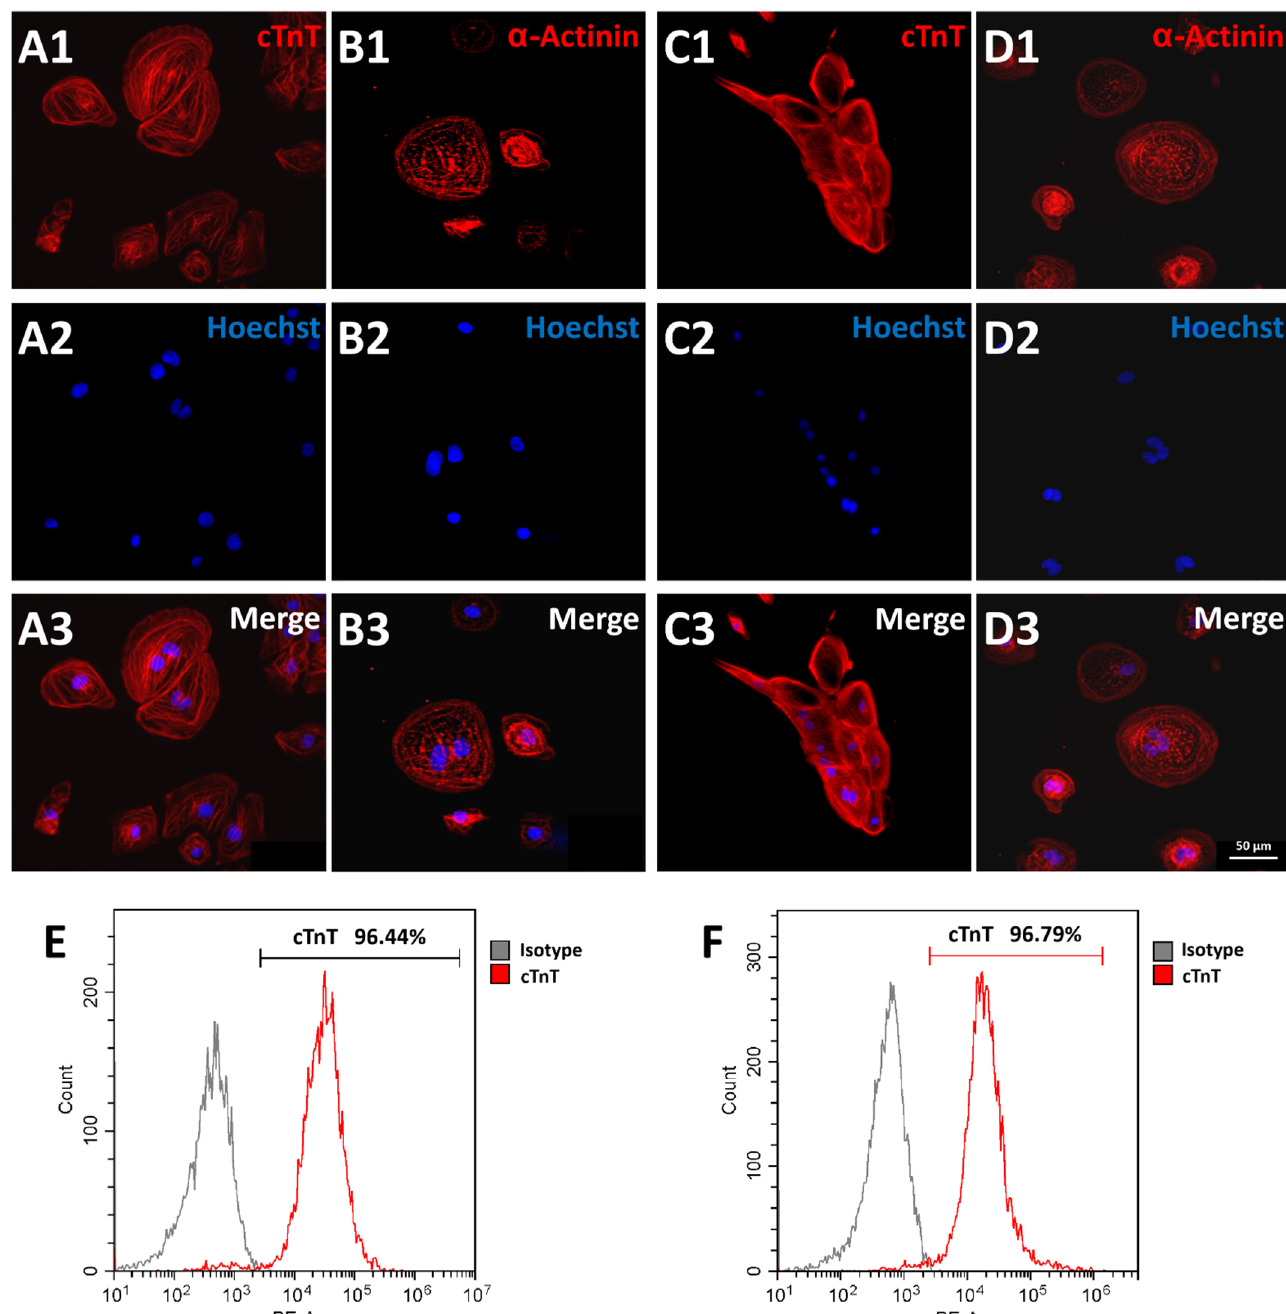
Figure 3. Characterization of Control and LQTS Cardiomyocytes. Ctrl-CMs and LQTS-CMs were positive for cardiomyocyte markers cTnT (( A1 – A3 ), Ctrl-CMs; ( C1 – C3 ), LQTS-CMs) and α -actinin (( B1 – B3 ), Ctrl-CMs; ( D1 – D3 ), LQTS-CMs). Flow cytometry analysis suggested that both Ctrl-CM and LQTS-CM consisted of ≥ 95% cTnT positive cells (( E ), Ctrl-CMs; ( F ), LQTS-CMs). Flow cytometry graphs and immunofluorescence images are representative samples. All experiments were of n = 3 or